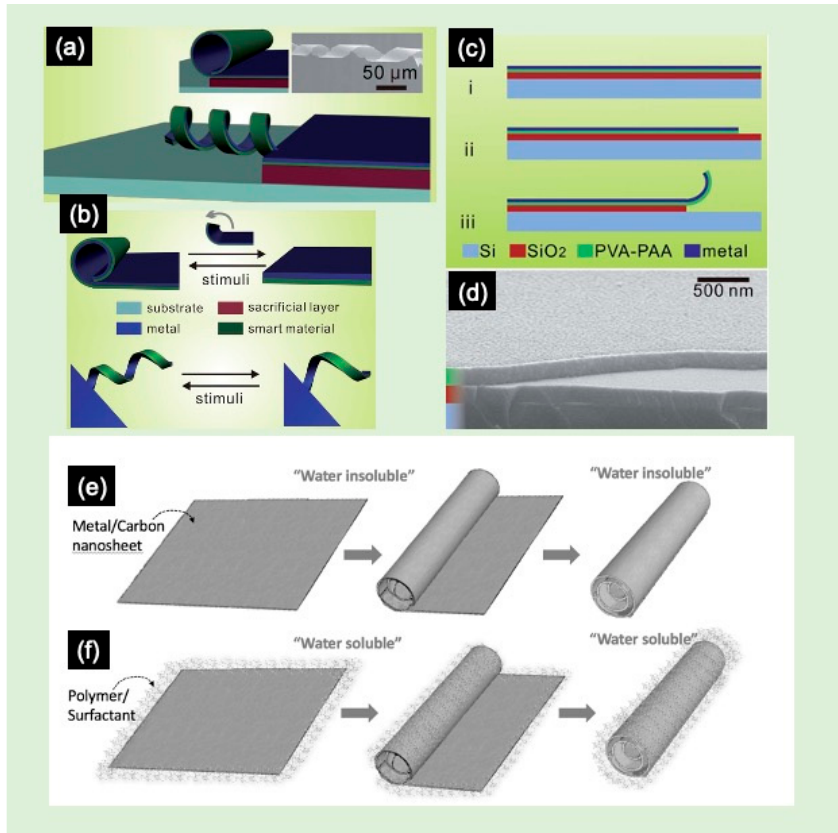
Figure 4. ( a – c ) Illustration of the basic process to fabricate bilayered micro-scrolls: ( i ) deposition of the polyvinyl alcohol–poly(acrylic acid) (PVA–PAA) and metal bilayer, ( ii ) lithographic patterning,